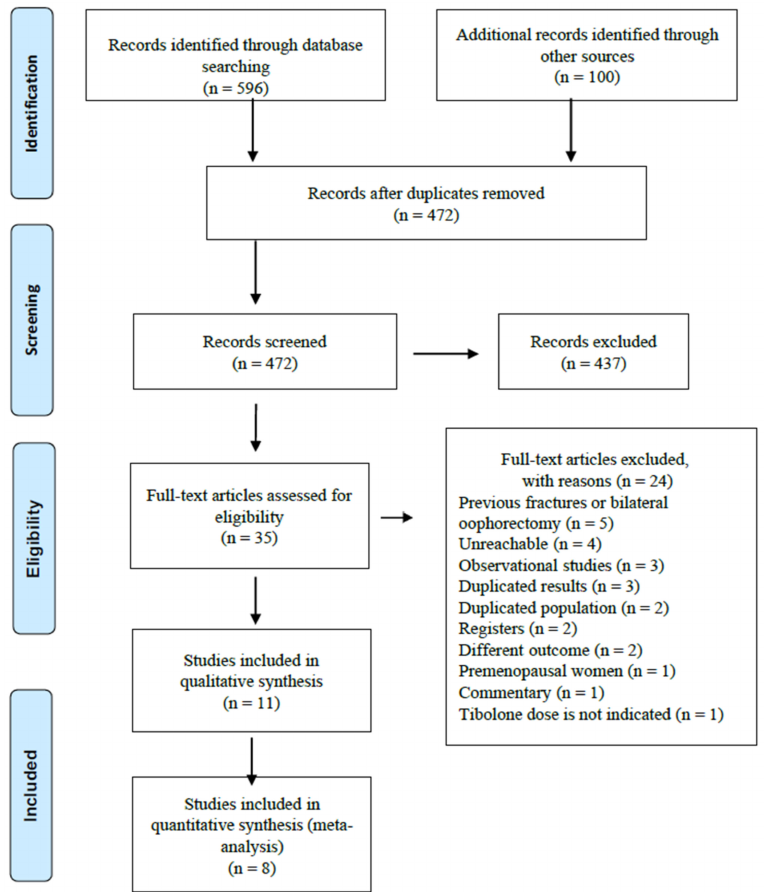
Figure 1. Flow chart of the number of studies included and excluded in the